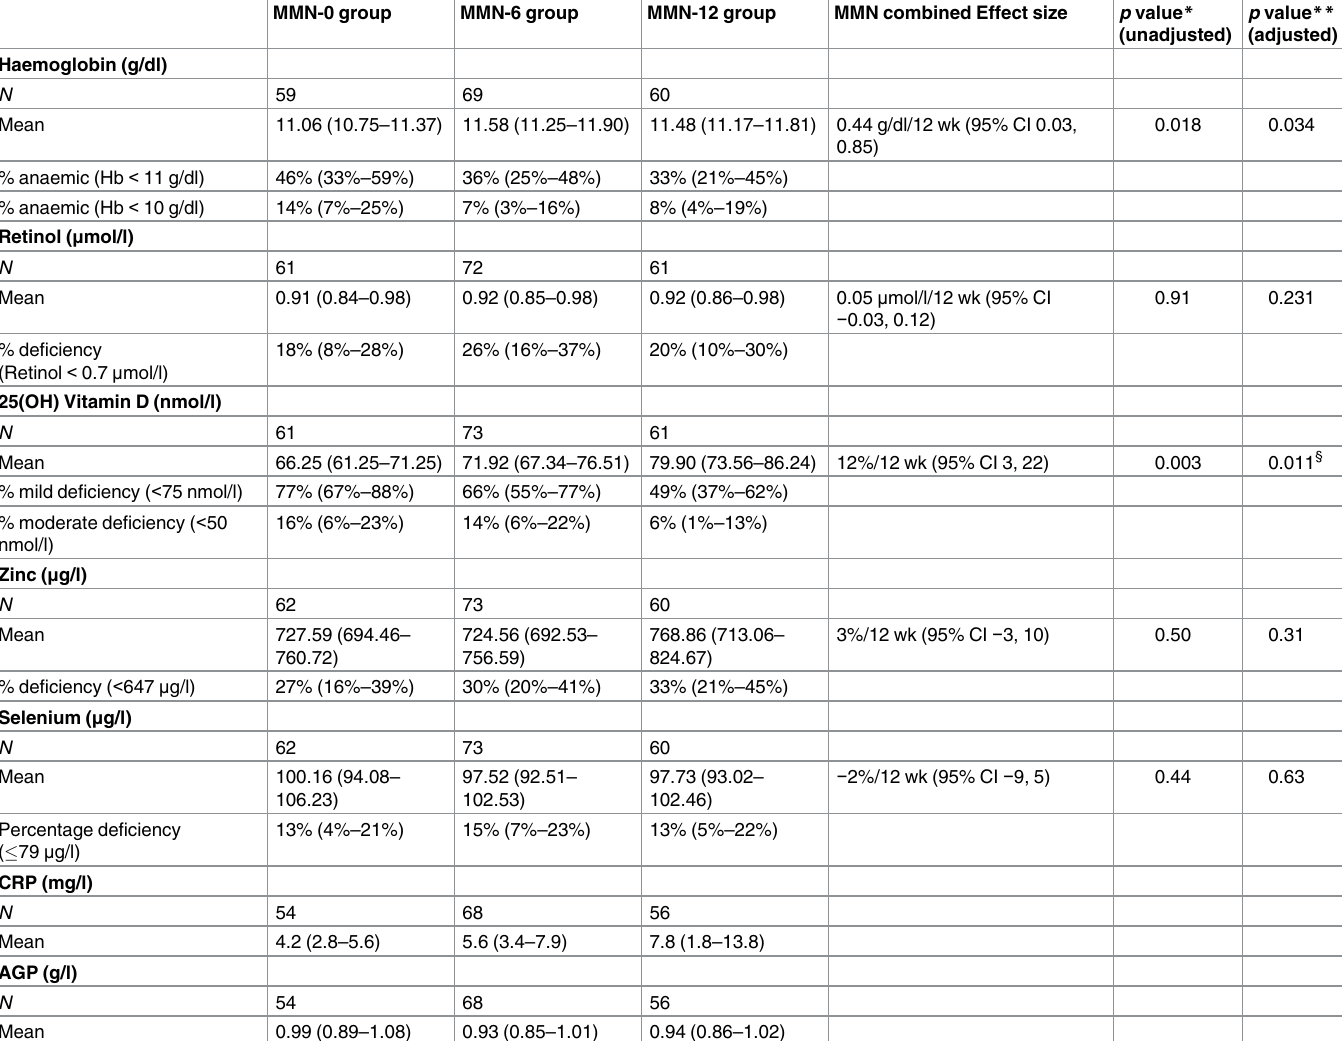
Table 5. Haematological outcomes after 12 wk of